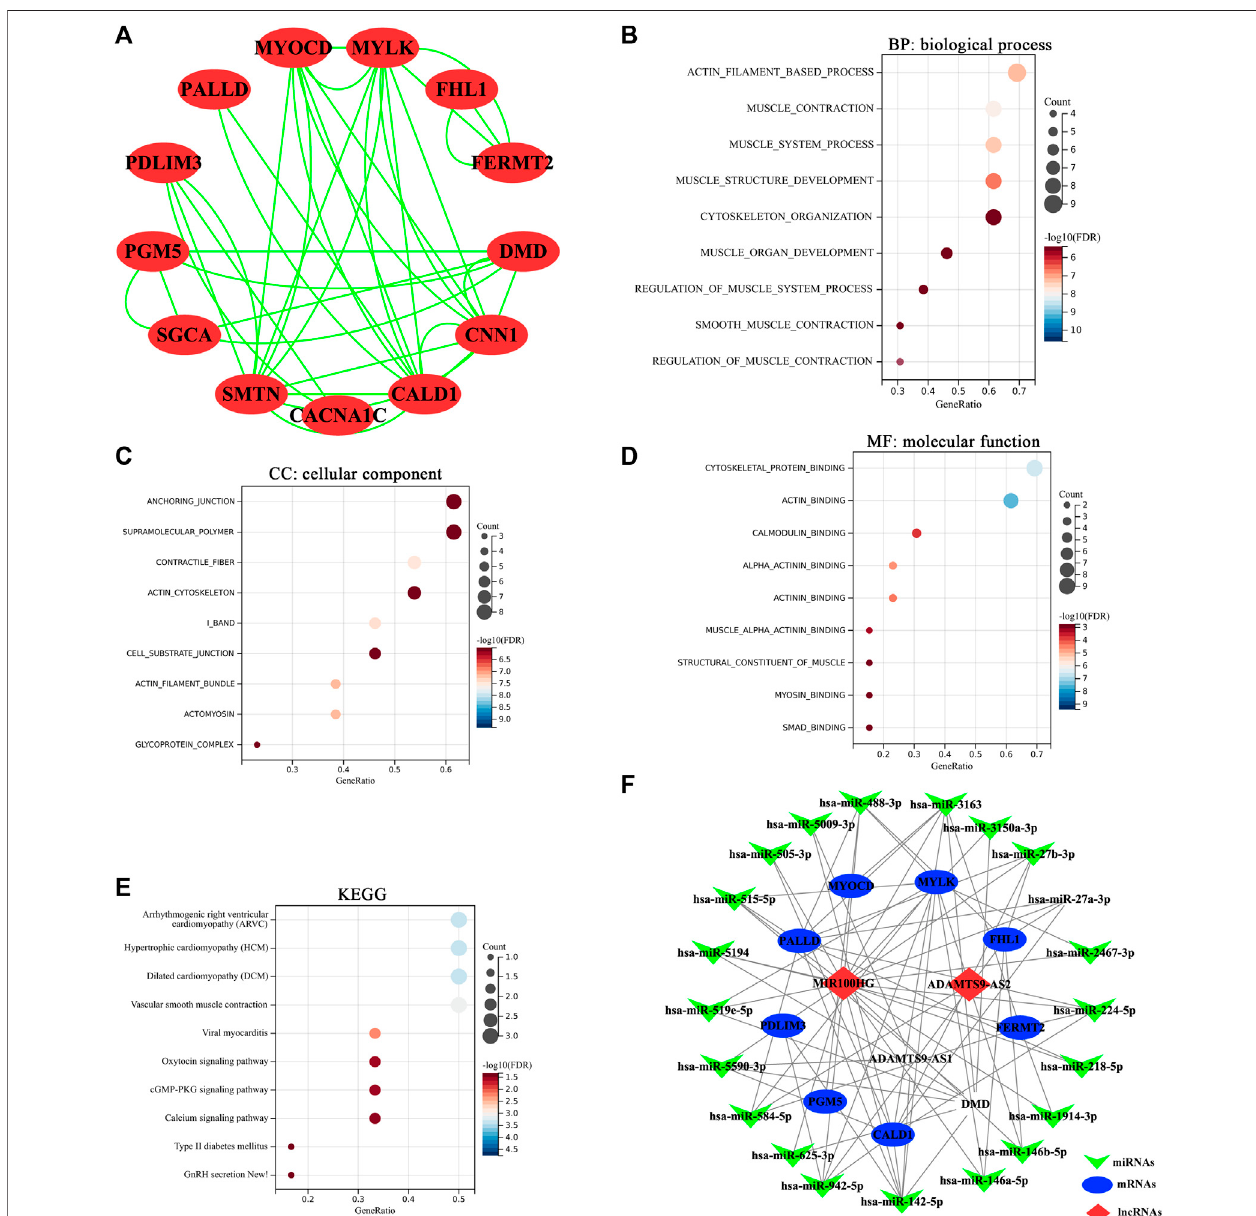
FIGURE6|(A) Diagramofprotein-proteininteraction (PPI)network.Each dotrepresentedanode.Themorelinesegmentsconnectedtothenode,thegreaterthe degree of this node. (B) The top 10 signi fi cantly enriched biological process terms of mRNAs in PPI network. (C) The top 10 signi fi cantly enriched cellular component terms of mRNAs in PPI network. (D) The top 10 signi fi cantly enriched molecular function terms of mRNAs in PPI network. (E) The 10 signi fi cantly enriched KEGG pathways of mRNAs in PPI network. Horizontal axis: the number of enriched genes; vertical axis: the corresponding biological process; Adj. p -value < 0.05 were considered statistically signi fi cant.Thecolorofthebubbleindicatestheadjusted p -valueoftheGOtermsorpathways,andthesizeofthebubble signi fi esthenumberof genes associated with a term. (F) The lncRNA-miRNA-mRNA competing endogenous RNA (ceRNA) network in bladder cancer. The invaginated triangles indicate miRNAs in green, ellipses represent mRNAs in blue and rhombus represent lncRNAs in red.